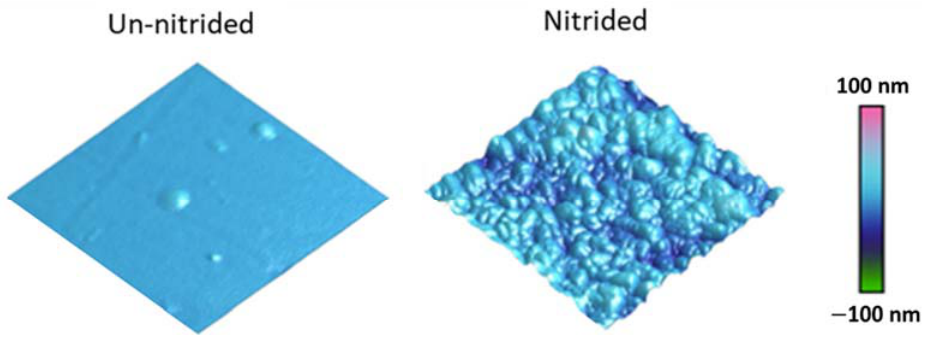
Figure 1. AFM images of Zircaloy-4 with and without